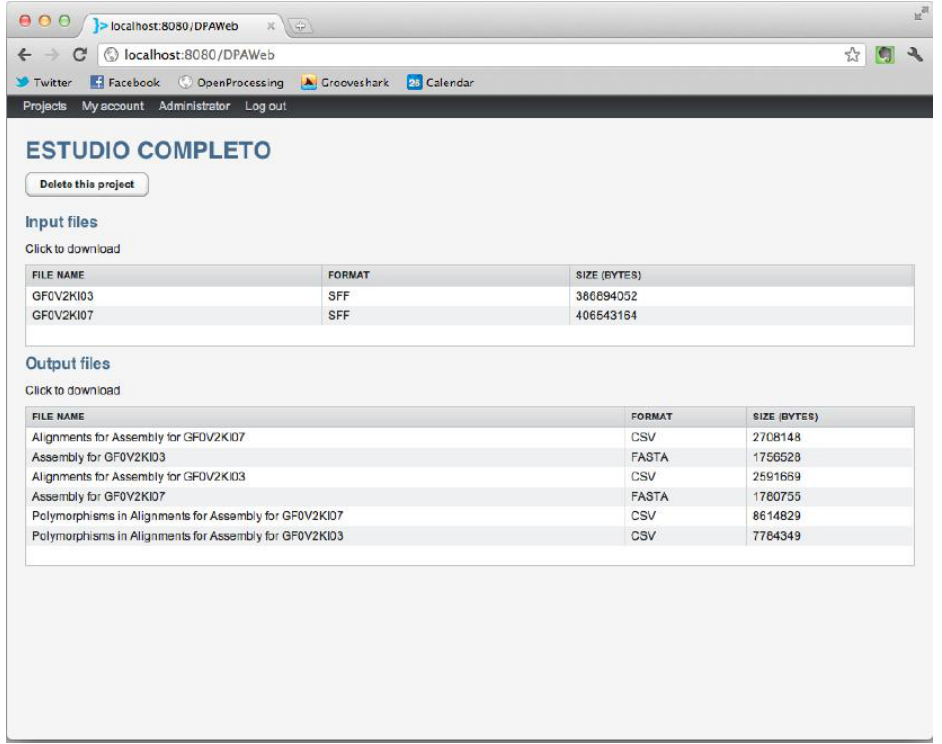
Figure 3: Screenshot of the graphic user interface of